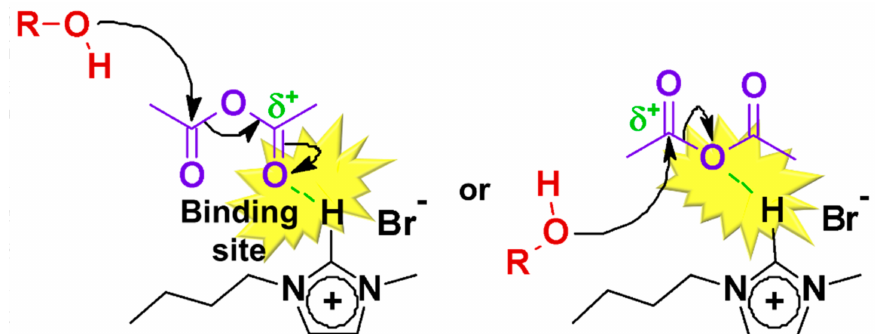
Figure 40. Possible H-bond activation with H-bond formation during O -acetylation of alcohols with acetic anhydride in 1-butyl-3-methylimidazolium bromide under sonication at 30 ◦